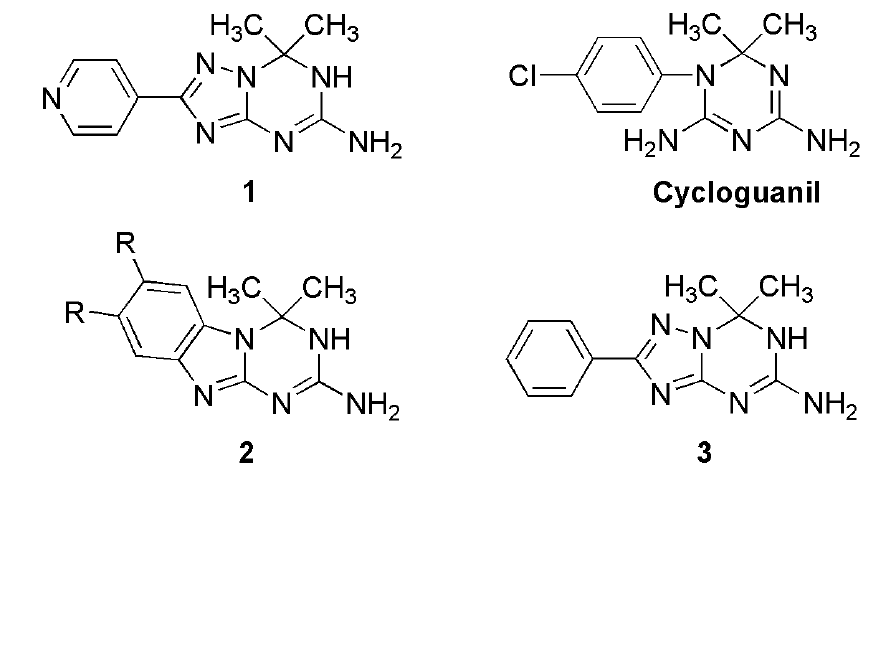
Figure 1. The title molecule 1 , cycloguanil, and structurally related gem -dimethyl substituted fused